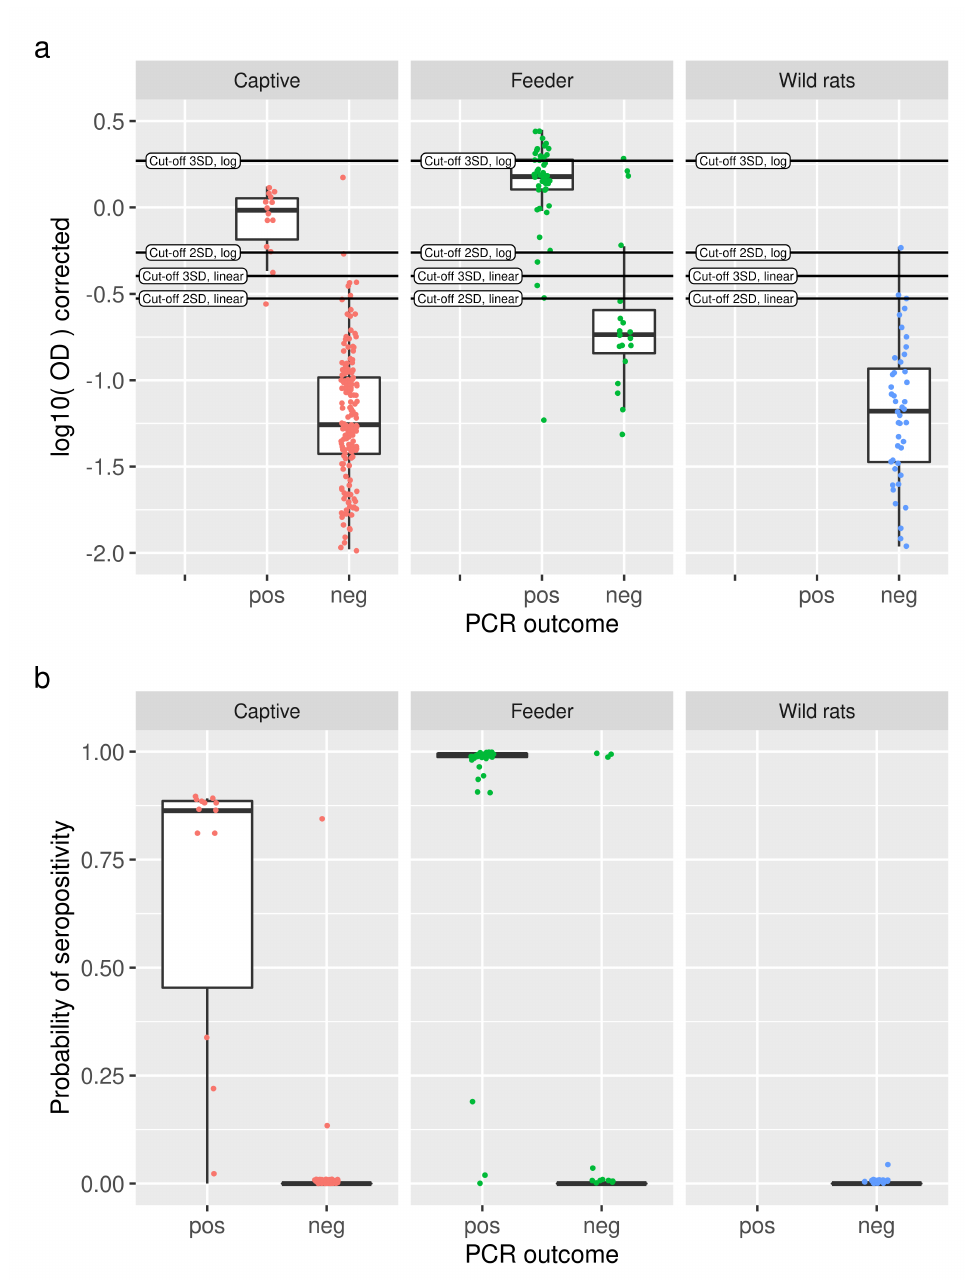
Figure 4. ( a ) For each study (panels), log-transformed OD values are shown as slightly jittered points with a boxplot, split into RT-qPRC positive and negative animals. Cut-off values are indicated as horizontal lines. ( b ) Comparison of predicted probabilities of seropositivity from the binary mixture models (dots, slightly jittered, with boxplot) with RT-qPCR outcomes (x axis) for the three studies under consideration (panels). With a few exceptions, high probabilities of seropositivity are observed for positive RT-qPCR results, and vice